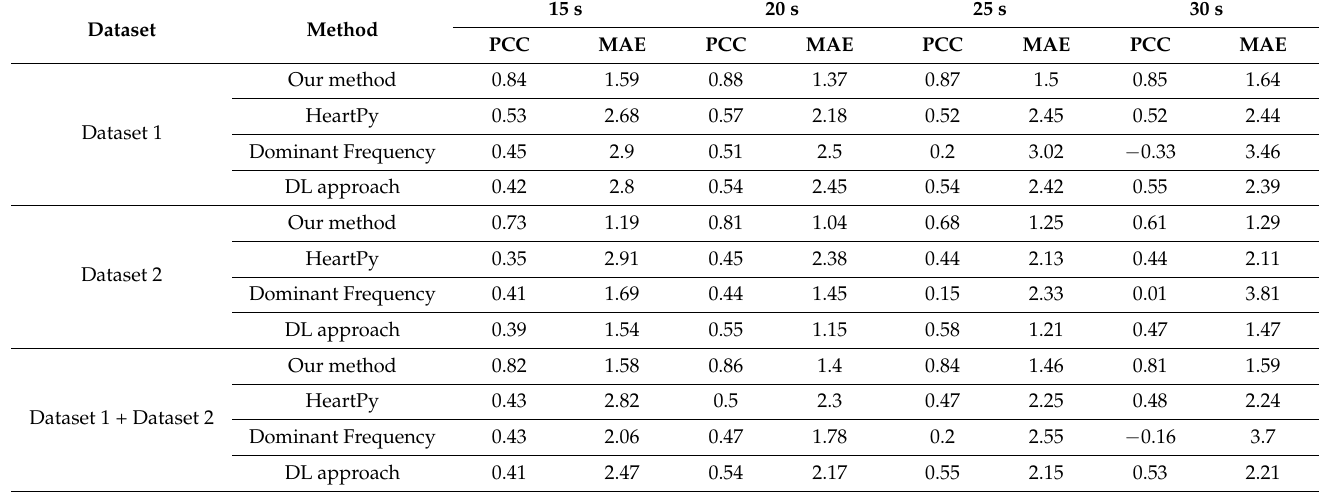
Table 2. Average mean absolute error (MAE), interpretable in breaths per minute, and Pearson’s correlation coefficient (PCC) achieved with the proposed ML-method and two baseline methods, using different window sizes. The results are achieved using leave-one-subject-out (LOSO) cross- validation, on three dataset combinations.